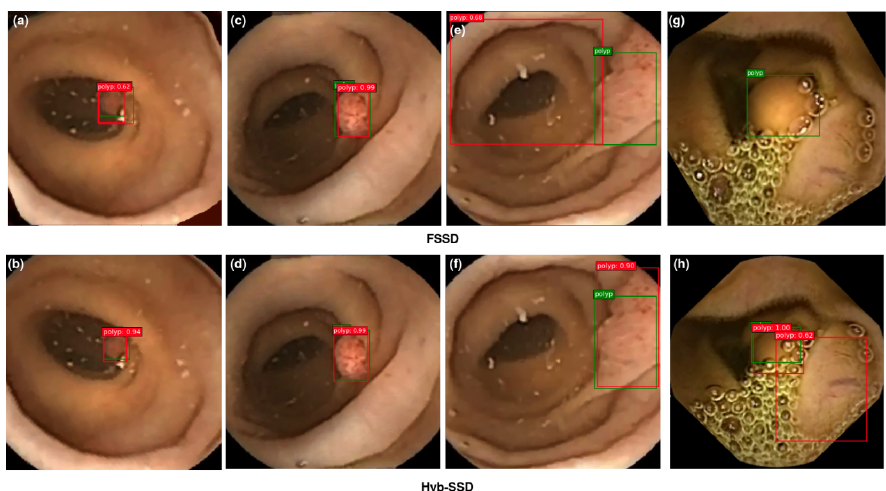
Figure 11. Qualitative results comparison between FSSD300 ( a , c , e , g ) and the proposed Hyb-SSDNet ( b , d , f , h ) on the WCE polyp test set. True bounding boxes with IoU of 0.5 or higher with the bounding predicted boxes are drawn in green and red colors, respectively.